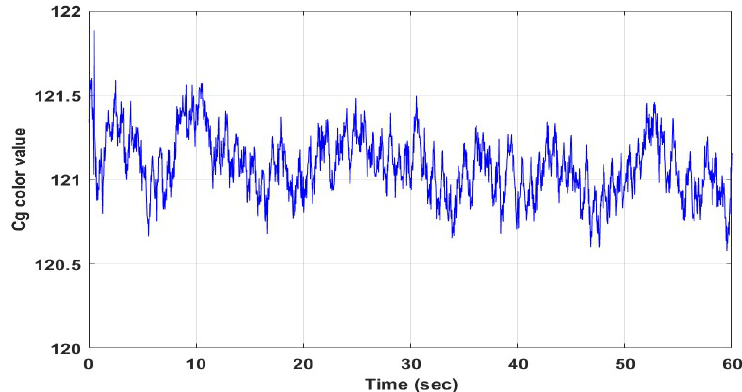
Figure 7. Cg signal recorded for 60 s.